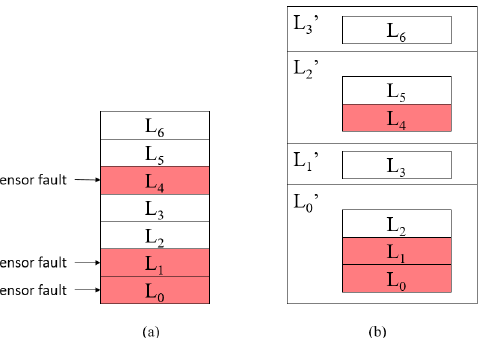
Figure 4. ( a ) Seven-layer system with three disabled layers. ( b ) The four-layer system generated by the fault model reconstruction method.